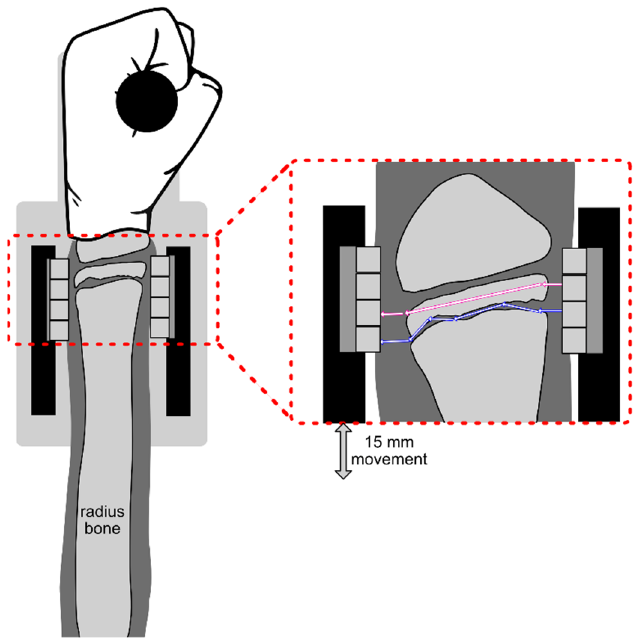
Figure 7. The left forearm is placed in the device with the transducers of the motorized sled positioned around the assumed location of the growth plate (left). The acoustic wave propagation through the growth plate (blue) and the radius bone (pink) is depicted in the enlarged detail inset on the right. The exact location of a potentially open growth plate varies between